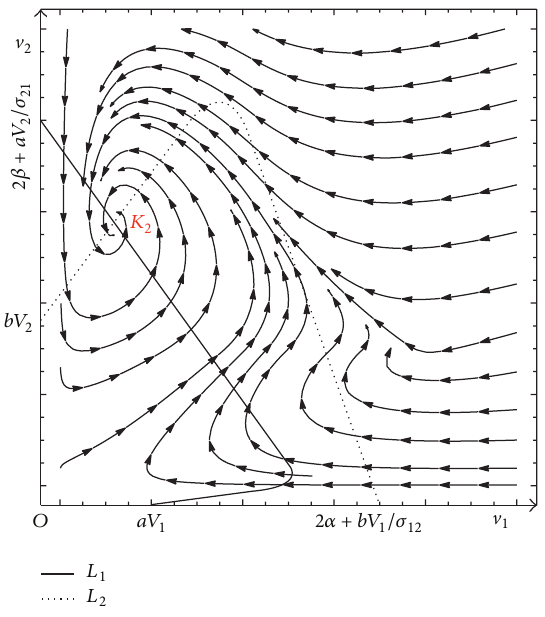
Figure 5: The unique positive equilibrium 𝐾 2